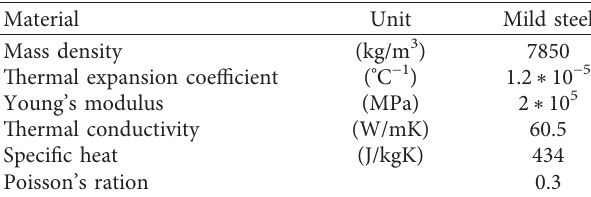
Figure 3: Schematic diagram of the experimental setup. Table 1: The workpiece material